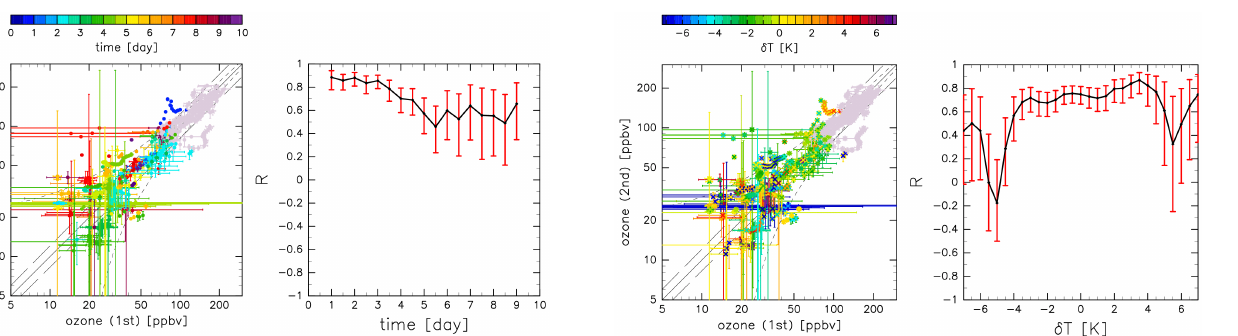
Fig. A6. As for Fig. A5 but for examining the consistency between sonde data and the analysis